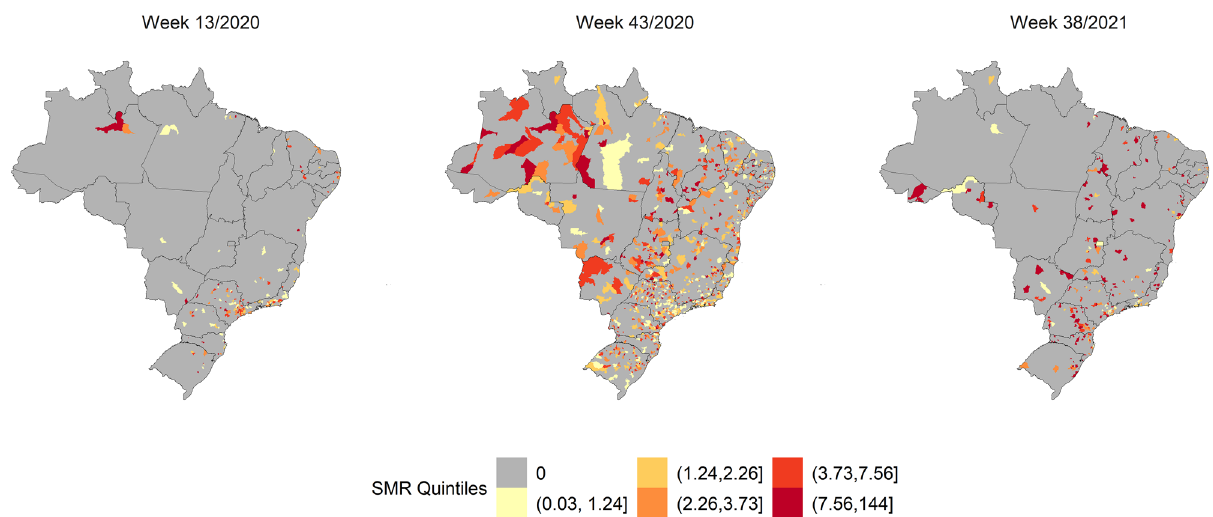
Figure 2. SMR quintiles by Brazilian municipalities in weeks 13/2020, 43/2021, and 38/2021. The map was generated using public domain shapefiles provided by the Brazilian Institute of Geography and Statistics (https:// geoftp. ibge. gov. br/ organ izacao_ do_ terri torio/ malhas_ terri toria is/ malhas_ munic ipais/ munic ipio_ 2021/ Brasil/ BR/ BR_ Munic ipios_ 2021. zip). The figure was generated by the authors using the R 4.0.5 software 9 and the packages ggplot2 10 , sf 11 and tidyverse 12